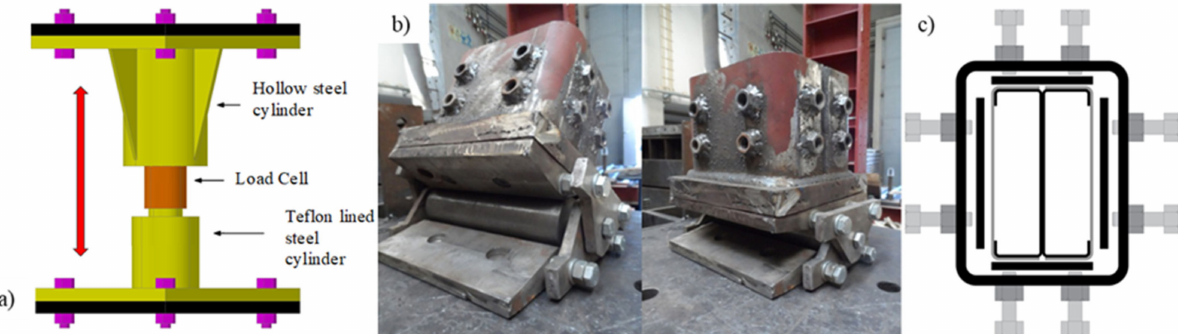
Figure 3. ( a ) Schematic view of the device built to measure the generated axial forces. ( b )